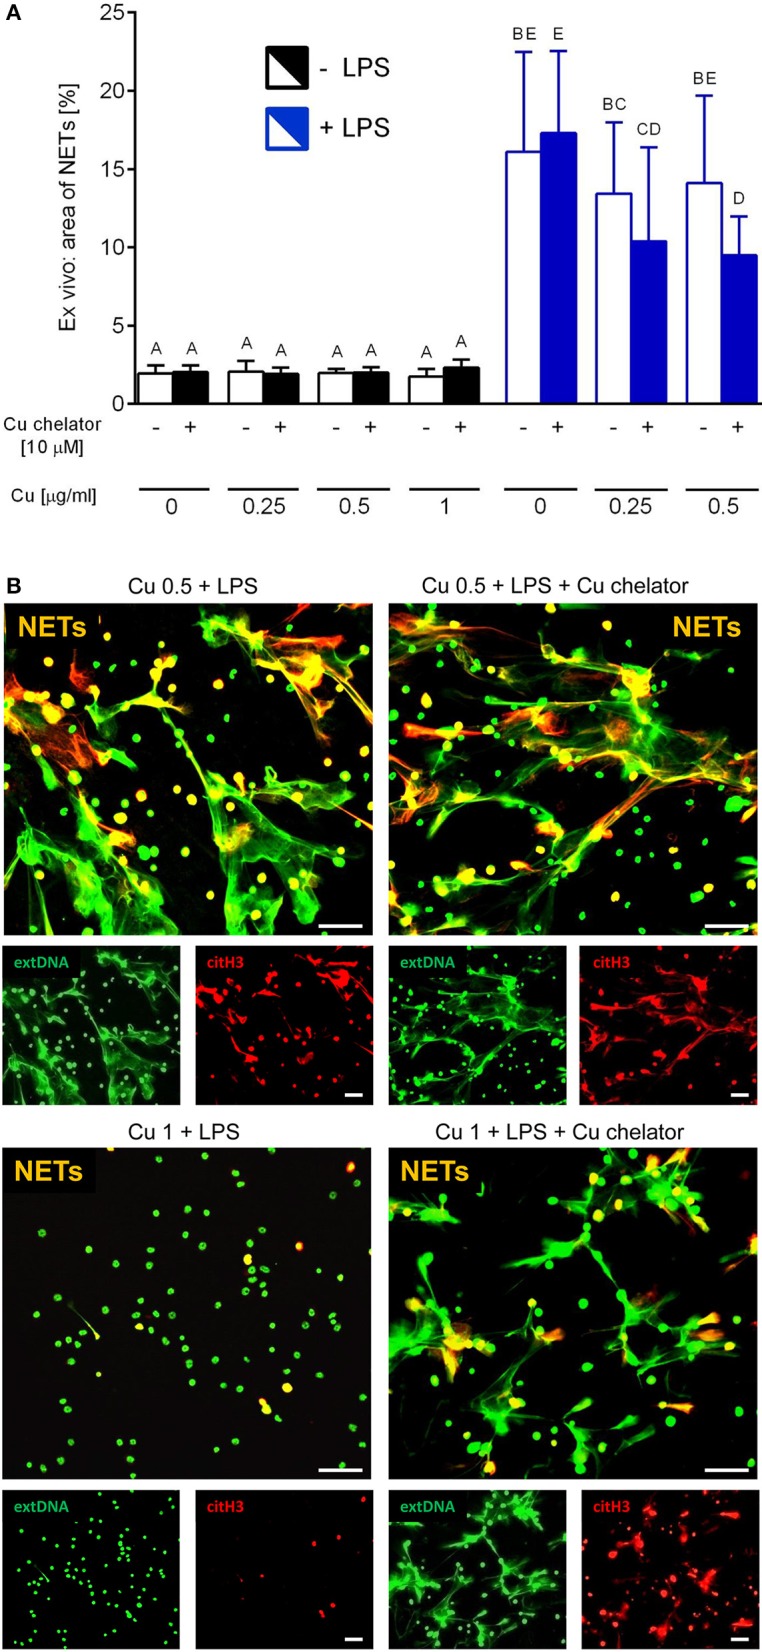
Neutrophil extracellular trap (NET) formation in the presence of exogenous copper. Neutrophils were either incubated with LPS (+LPS), various concentrations of copper (Cu), or left alone. Additionally, some cells were stimulated with LPS and/or copper chelator when co-cultured with the varying concentrations of copper. In all groups, neutrophil capacity to form NETs was quantified (A). Different letters indicate statistically significant differences between groups using one-way ANOVA (post hoc Bonferroni). Representative images of NETs formed by LPS in the presence of copper with or w/o copper chelator are shown in (B). Extracellular DNA (extDNA) is shown in green and citrullinated histone H3 (citH3) is shown in red. To visualize co-localization of NET components, the images from each channel were overlaid (NETs, overlay; orange). The scale bar indicates 50 μm.